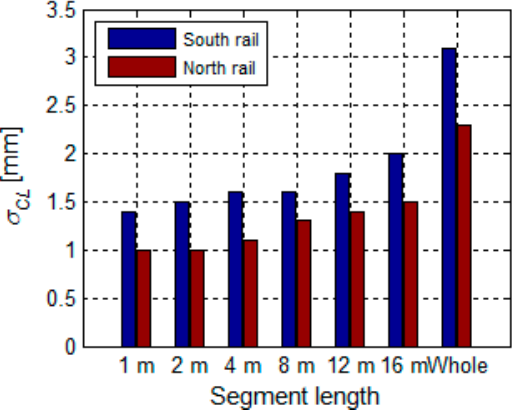
Figure 19. ( a ) The vertical variances and ( b ) the height differences in relation to the length of the segment.